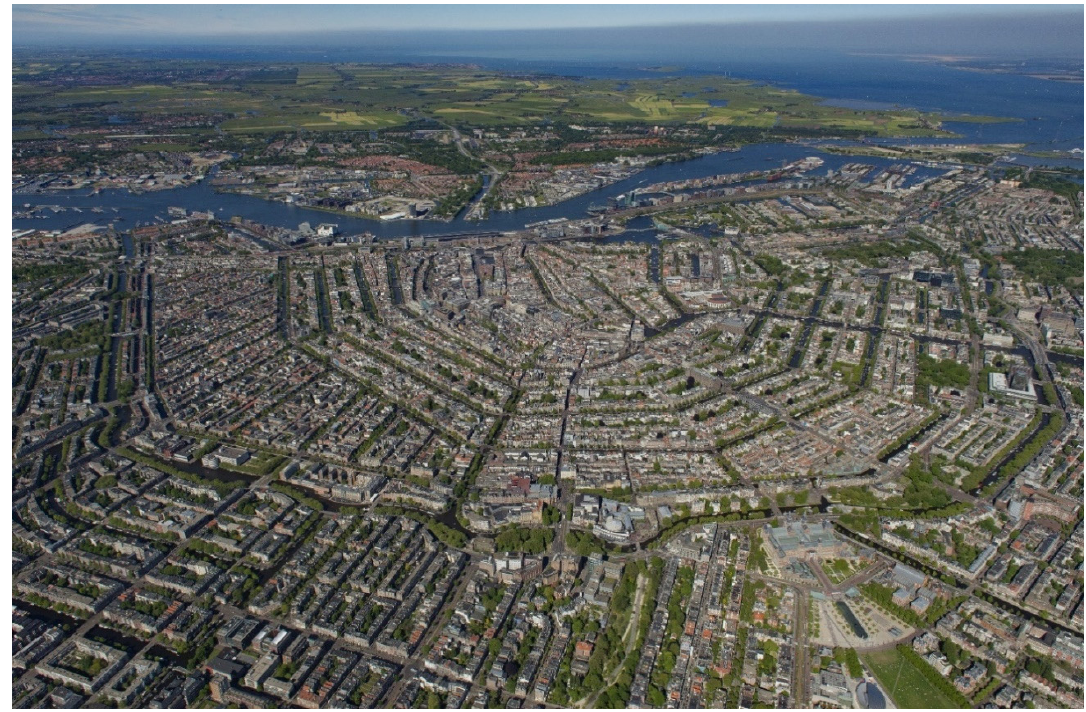
Figure 1. Aerial view of the city of Amsterdam showing the urban structure of the 17th century (Source: Office for Monuments and Archaeology, City of Amsterdam, photo by Cor Harteloh; with permission).